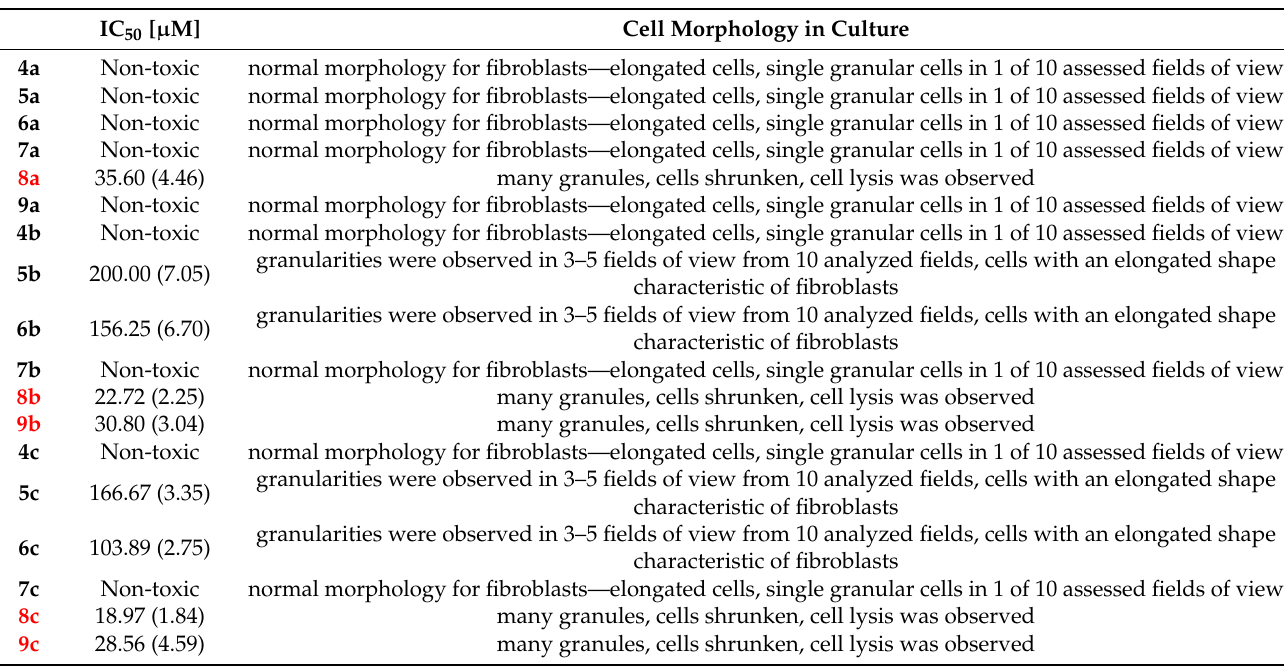
Table 1. The cell viability [IC 50 (SEM) n = 3] and the evaluation of the morphology of cells treated with the tested compounds. IC 50 [ µ M] Cell Morphology in Culture 4a Non-toxic normal morphology for fibroblasts—elongated cells, single granular cells in 1 of 10 assessed fields of view 5a Non-toxic normal morphology for fibroblasts—elongated cells, single granular cells in 1 of 10 assessed fields of view 6a Non-toxic normal morphology for fibroblasts—elongated cells, single granular cells in 1 of 10 assessed fields of view normal morphology for fibroblasts—elongated cells, single granular cells in 1 of 10 assessed fields of view normal morphology for fibroblasts—elongated cells, single granular cells in 1 of 10 assessed fields of view normal morphology for fibroblasts—elongated cells, single granular cells in 1 of 10 assessed fields of